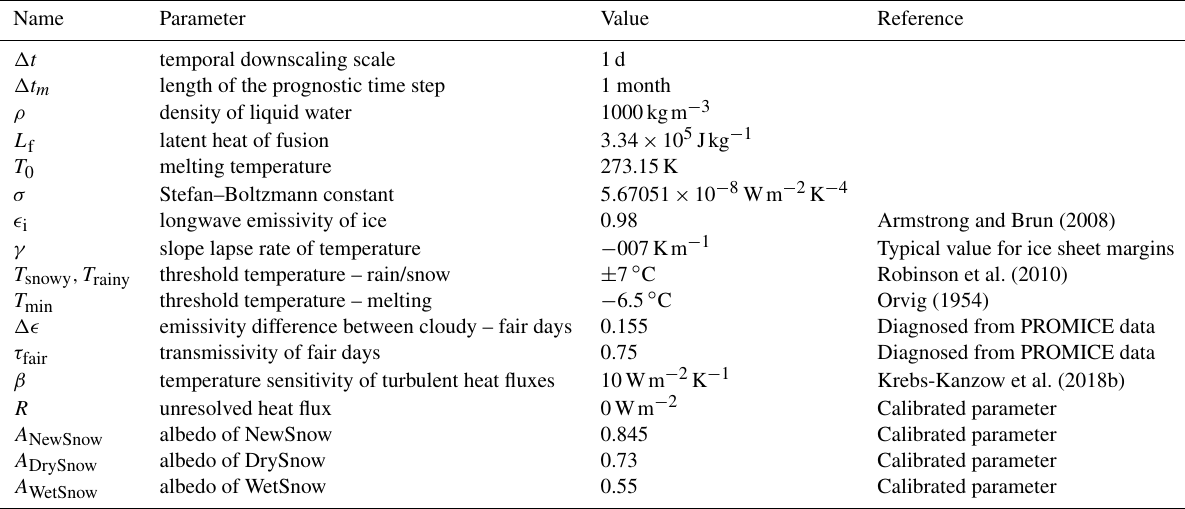
Table A2. Physical and empirical parameters used in this